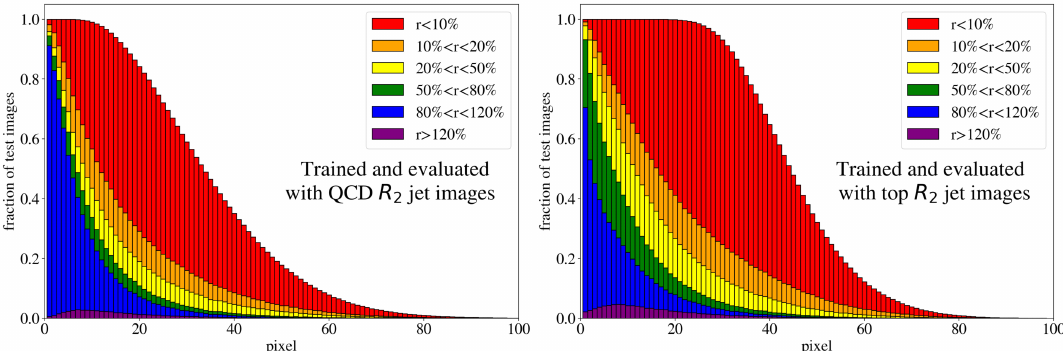
Figure 8 . Same as figure 4 but using the R 2 intensity remapping.